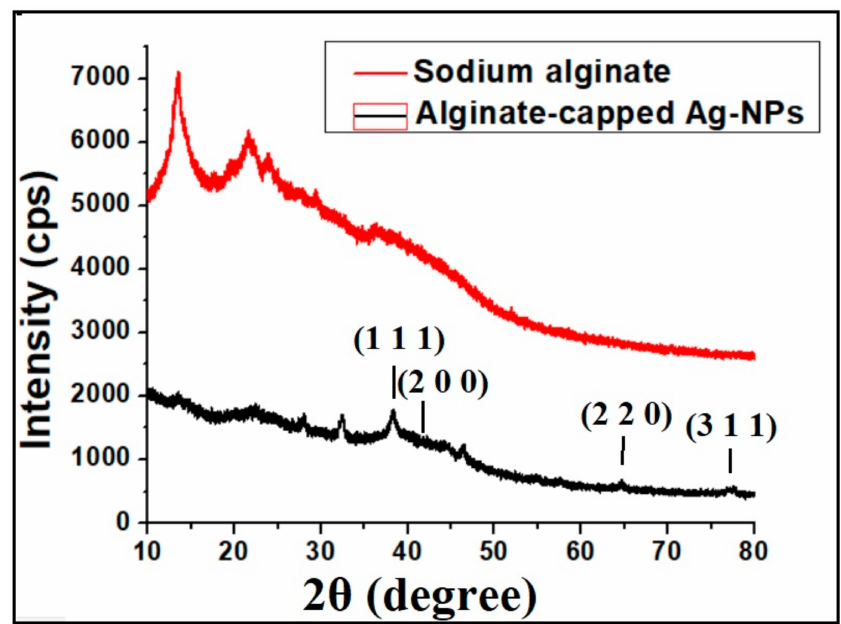
Figure 4. X-ray di ff raction pattern of sodium alginate and alginate-capped Ag-NPs after 48 h reaction time.